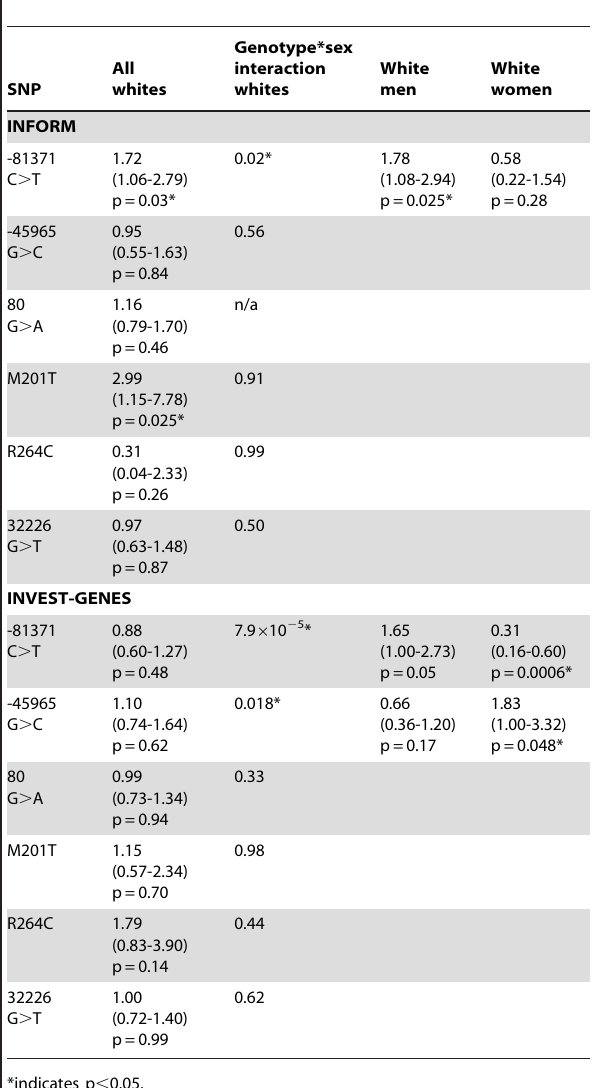
Table 3. Adjusted Hazard Ratios/Odds Ratios and 95% Confidence Intervals by Individual SNPs in